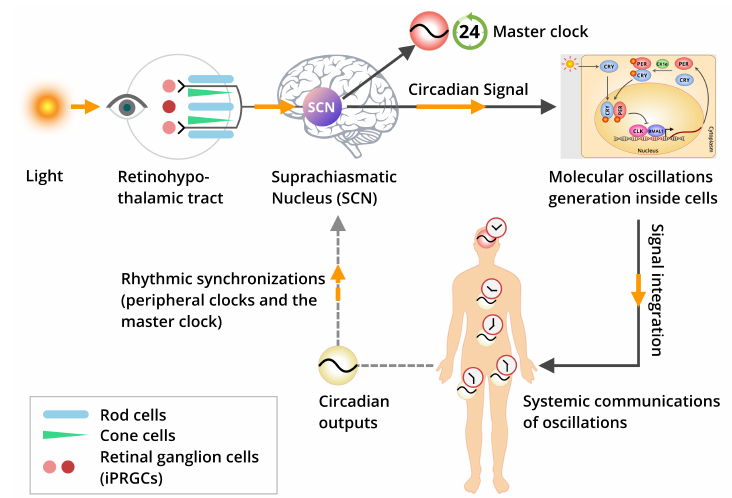
Figure 2. Schematic representation of the light entrainment and intercellular signal transmissions. The mammalian circadian systems are most sensitive to the light and dark cycles around the 24-h a day. The light serves as the most inevitable external zeitgeber to entrain the mammalian circadian rhythms. Usually, the photic signals from the light sources are received by the ipRGCs and reach the master clock, located at the SCN under the hypothalamus of the brain via RHT. In SCN, the primary oscillations are produced and get transmitted to the cellular-molecular level of distal peripheral tissues across the organism’s body. Thus, the different tissue-specific circadian outputs are produced. In addition, the locally regulated peripheral rhythms are integrated together to maintain circadian homeostasis, keeping a synchronization to the master